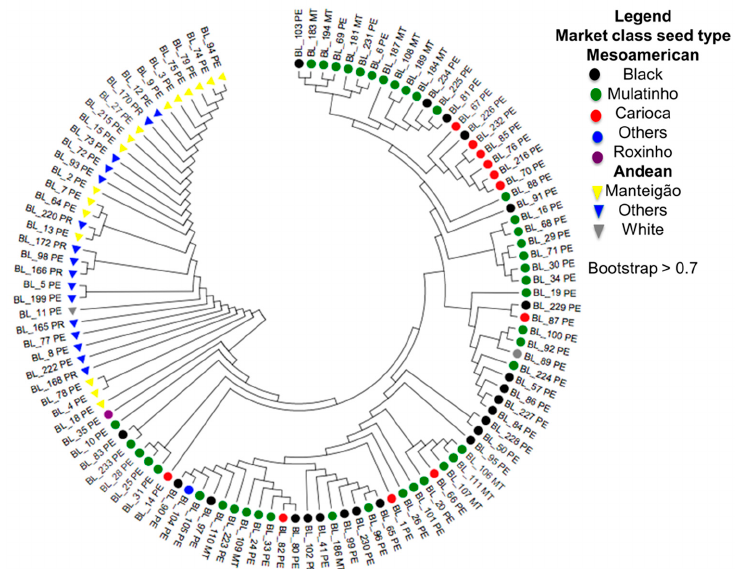
Figure 3. Phylogenetic tree of 110 common bean accessions genotyped with 28,823 SNPs. The color of each accession is based on different market class seed type. Plants 2021 , 10 , x